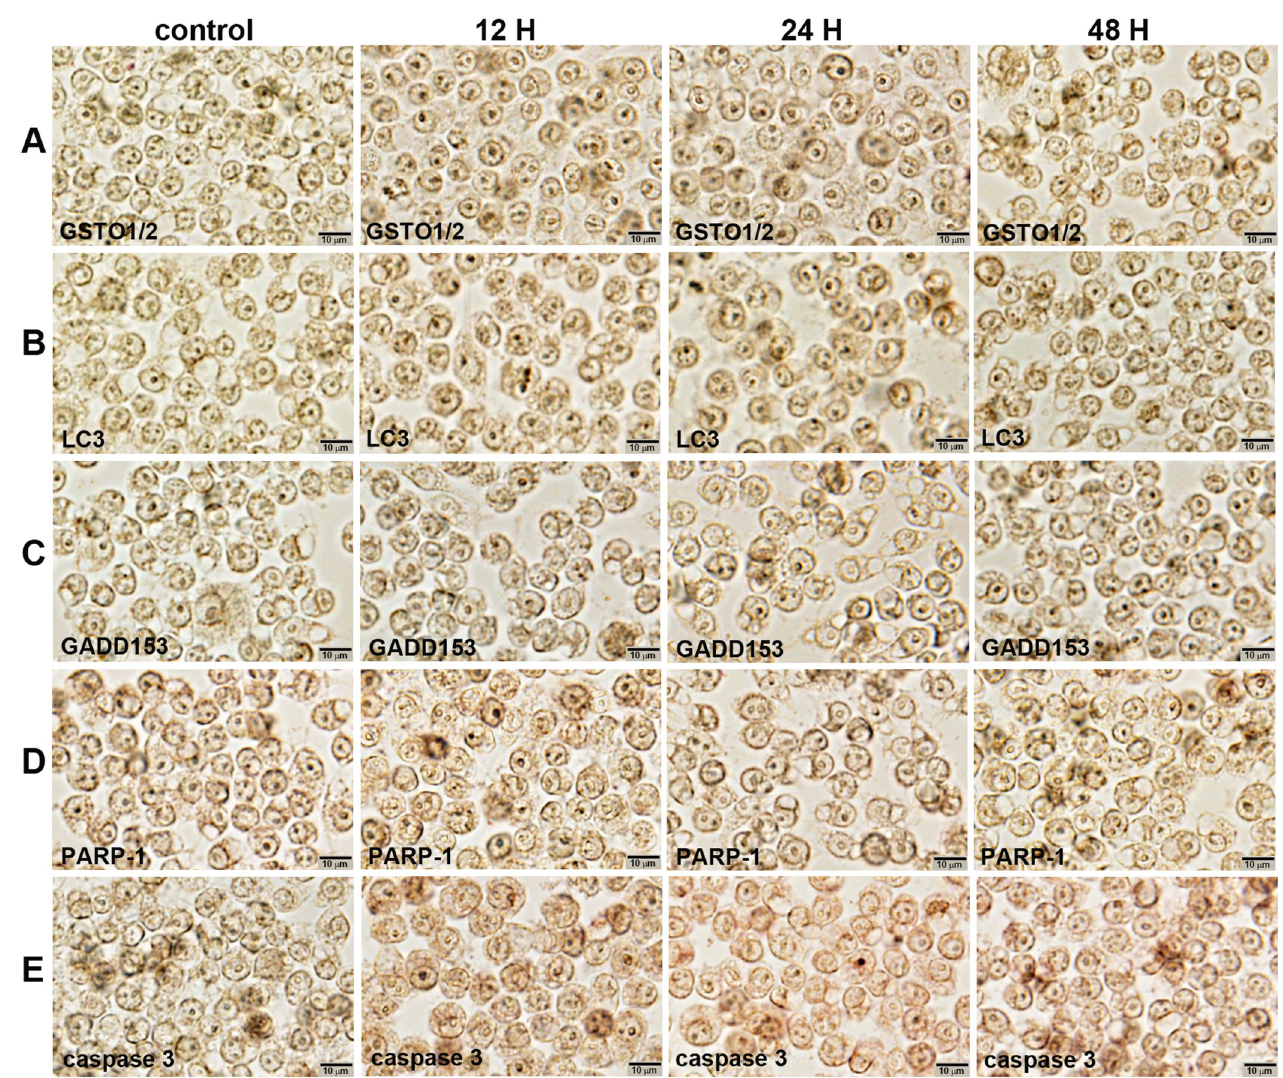
Fig 3. Immunocytochemical staining of GSTO1/2 (A), LC3 β (B), GADD153 (C), PARP-1(D), and caspase-3 (E) in RAW 264.7 cells after 10 μ g/mL PTX treatment for 0, 12, 24, and 48 hours. Noted the cytoplasmic (arrow heads) and nuclear (arrows) localization of different immunoreactions in monocytic round cells. No counter